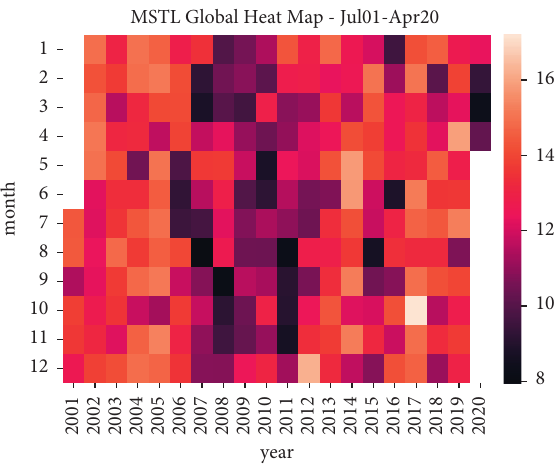
Figure 2: Global minimum spanning tree length (MSTLG) heat map. This figure represents the evolution of the minimum spanning tree length for a total of 27 stock indexes in North and Latin America, Europe, Asia, and Oceania for the period July 2001–April 2020. Black (khaki) color represents the minimum (maximum) values for the